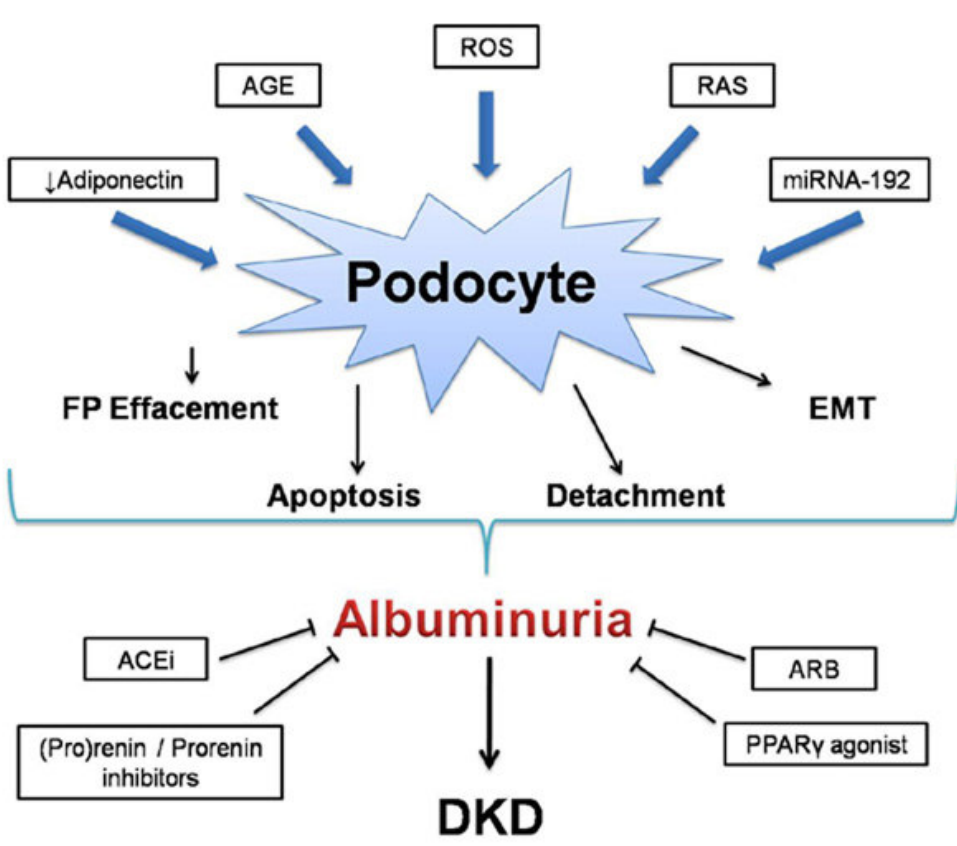
FIGURE 1. Mediators of podocyte injury in DKD. Several molecular pathways are known to contribute to podocyte injury in DKD. As depicted, these include, but are not limited to, the following: decreased adiponectin, production of advanced glycation end-products (AGEs), increased reactive oxygen species (ROS), activation of the RAS, and miRNA-192 all contribute to podocyte injury. Podocyte injury exhibits itself as foot process (FP) effacement, apoptosis, detachment, and EMT. Damage to the podocyte leads to increased albuminuria and exacerbates DKD. Agents known to inhibit this process include ARBs, ACEi, peroxisome proliferator-activated receptors (PPAR) agonists, and (pro)renin/prorenin